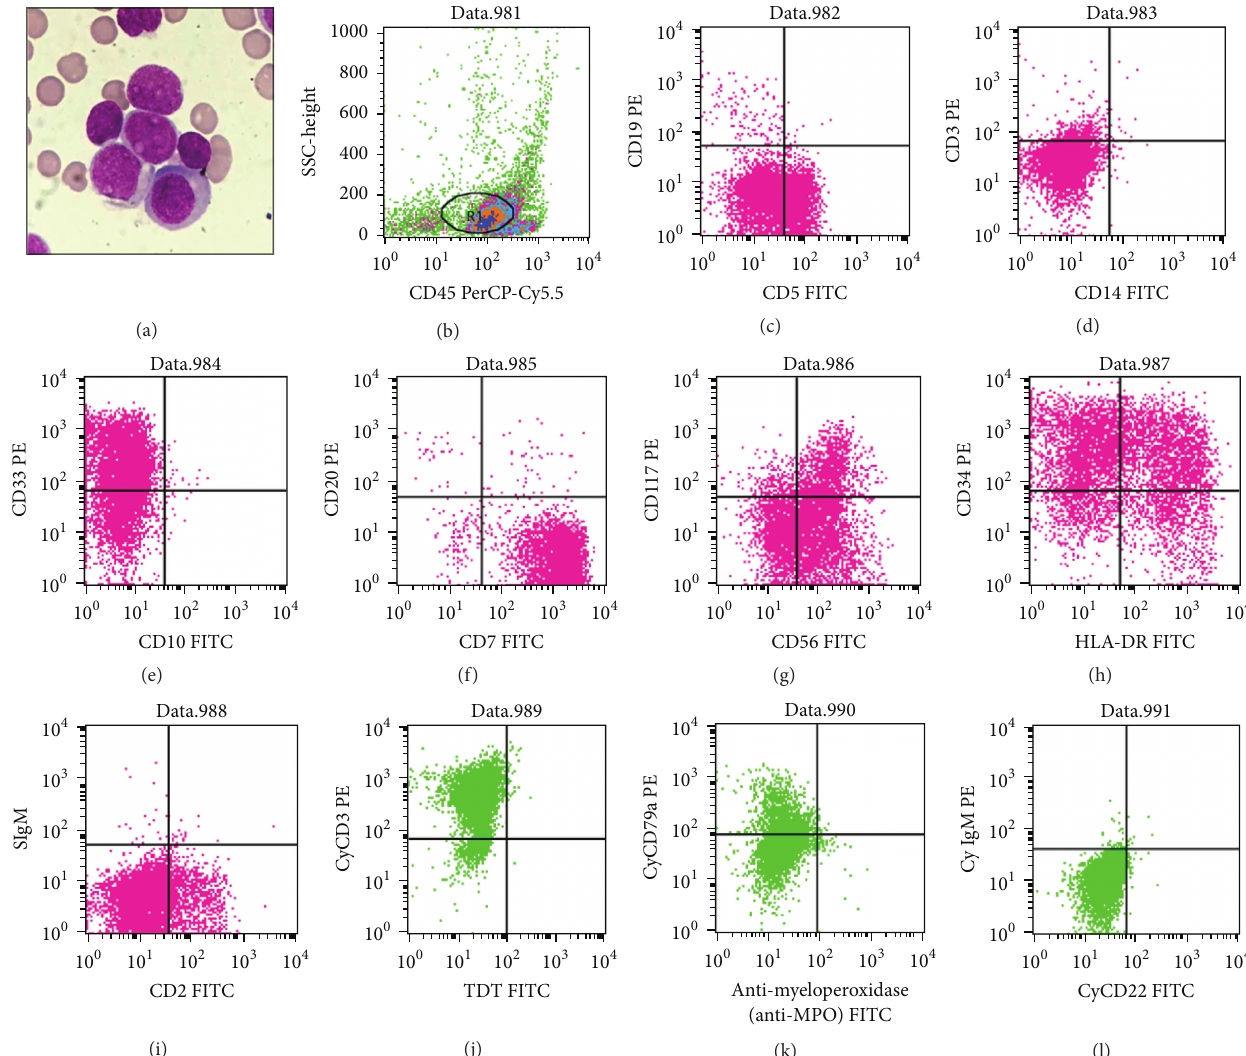
Figure 1: (a) May-Giemsa staining of bone marrow smear (magnification × 1000); (b–i) histogram of flow cytometry of bone marrow specimens (BD Bioscience, San Jose, CA, USA).